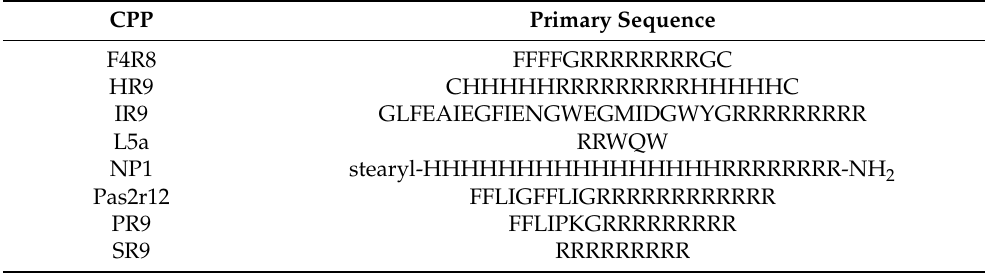
Table A1. Primary Sequences of cell-penetrating